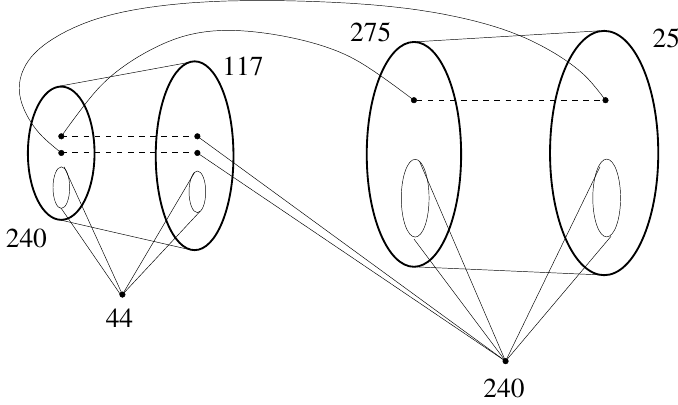
Figure 2: A graph with integer Sombor index and five different